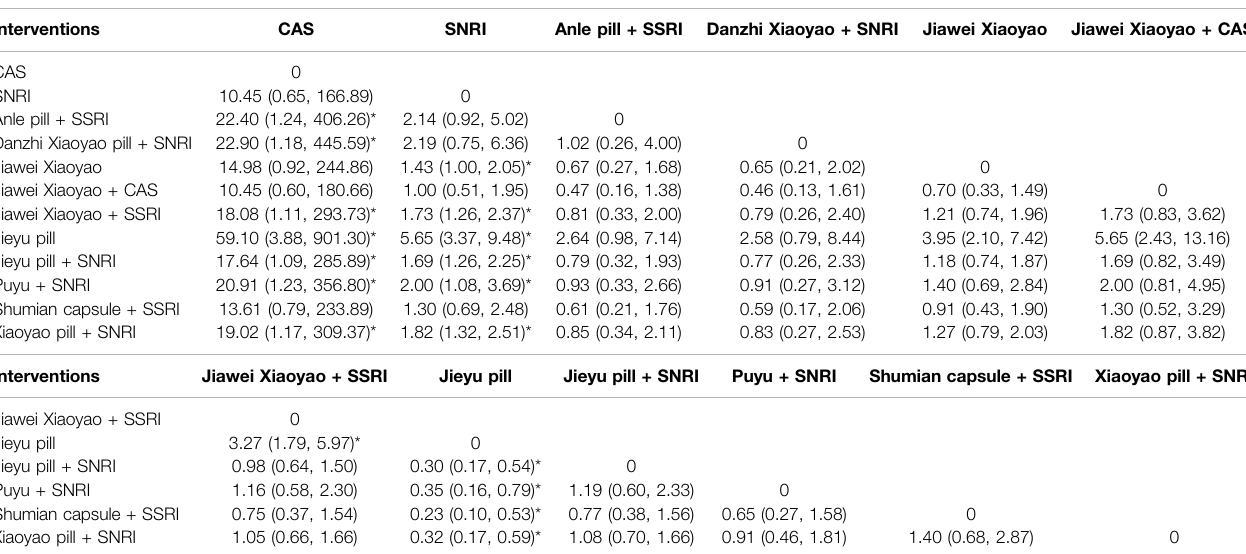
3.27, 95%CI (1.79, 5.97)]; the adverse reaction rate of Jieyu pill was lower than that of Jieyu pill + SNRI [RR = 0.30, 95%CI (0.17, 0.54)], Puyu + SNRI [RR = 0.35, 95%CI (0.16, 0.79)], Shumian Capsule +